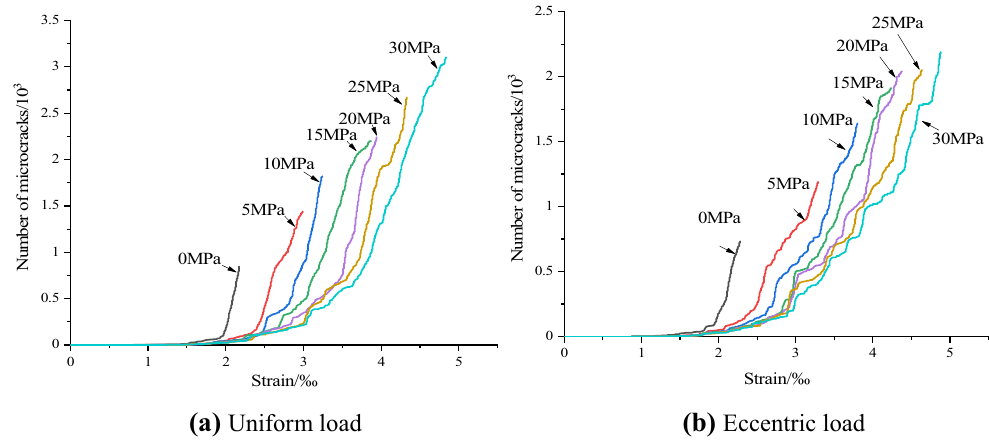
Figure 12. Relationship between crack number and axial strain.